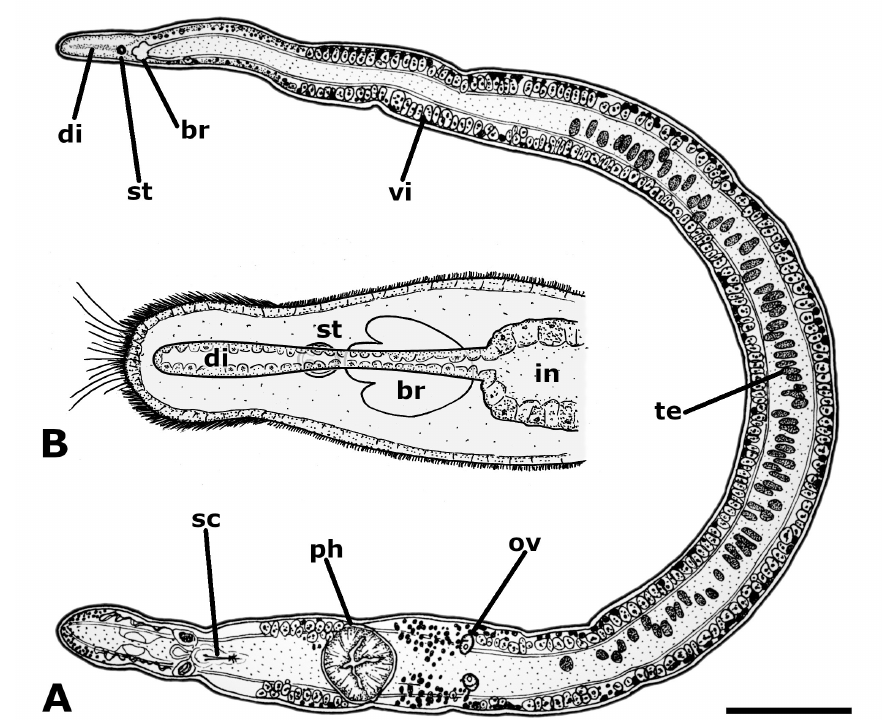
Fig. 1. Coelogynopora kenichii sp. nov. A . Live specimen. Scale bar = 250 µm. B . Schematic